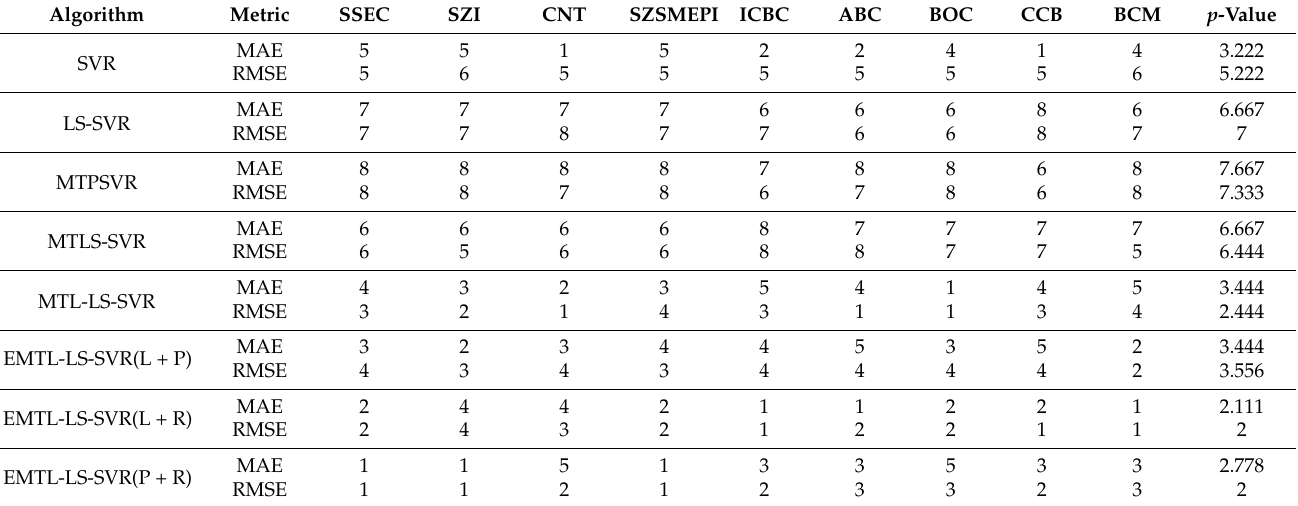
Table 3. Average ranks of all algorithms in the Friedman test on the two experimental